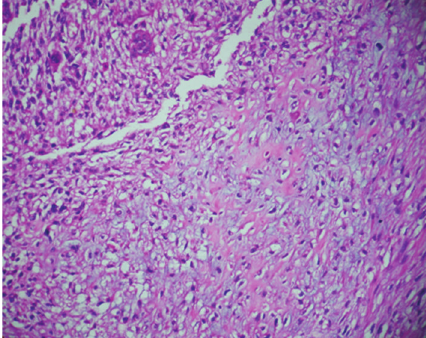
Figure 1: Spindle-shaped bizarre tumor cells along with pleomor- phic tumor giant cells and osteoclastic giant cells (H&E, 100x).